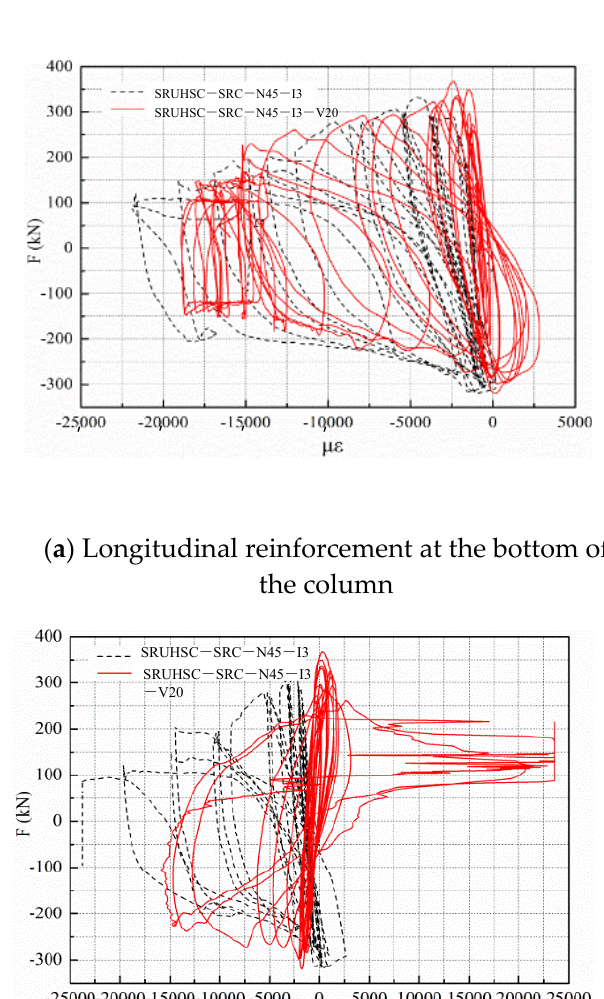
( b ) Ratio of residual displacement Figure 10. Residual deformation curves. 3.7. Strain Analysis The variations in longitudinal reinforcement, stirrups and steel bones in the structure can directly reflect the specific strain of each part of the whole structure in the process of deformation. It can be seen from Figure 11 that the variation trends of the two were similar, and both underwent compressive deformations. After loading for a certain period of time, the reinforcement was in the plastic deformation stage, but the strain variation range of the quasi-static test was larger than that in the rapid loading test. The stirrup strain of the quasi-static test was very small, as shown in Figure 11. In the process of loading, the stirrup strain value increased gradually at the beginning of loading. The strain value increased very quickly after a certain value in the stage of plastic deformation was reached. The stirrup strain had a reciprocating change and the strain value did not continue to increase at the end of the test, indicating that the degree of damage of the rapid-loading test was also more serious than that of the static test.